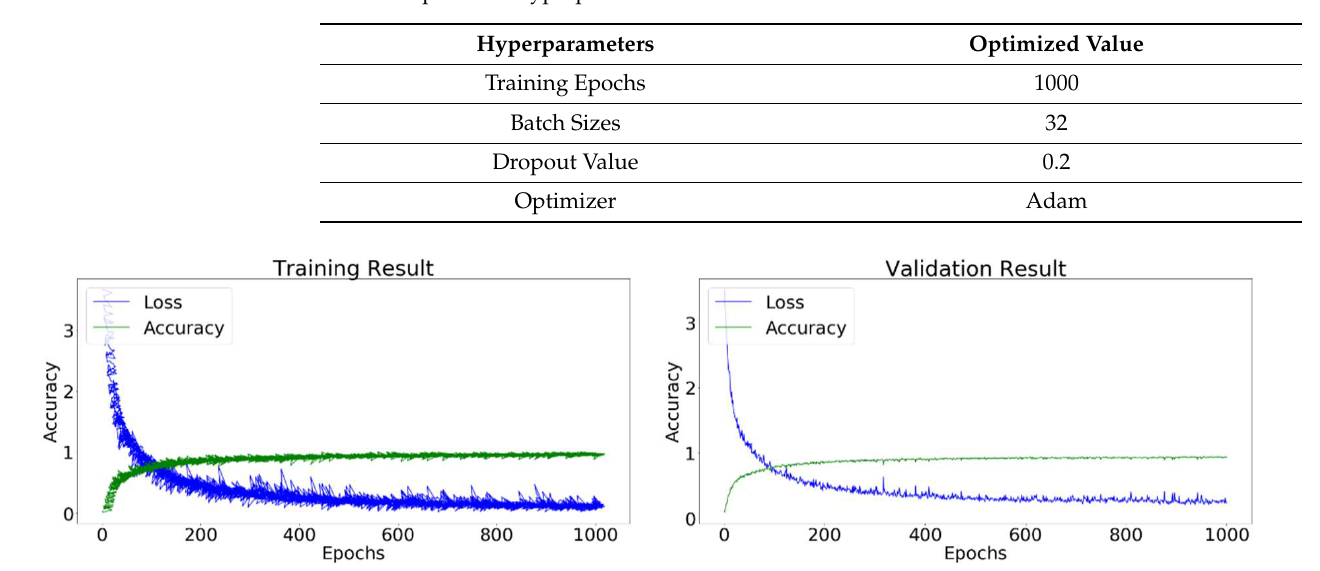
Table 3. Optimized hyperparameters of the Conv-4 DCNN.